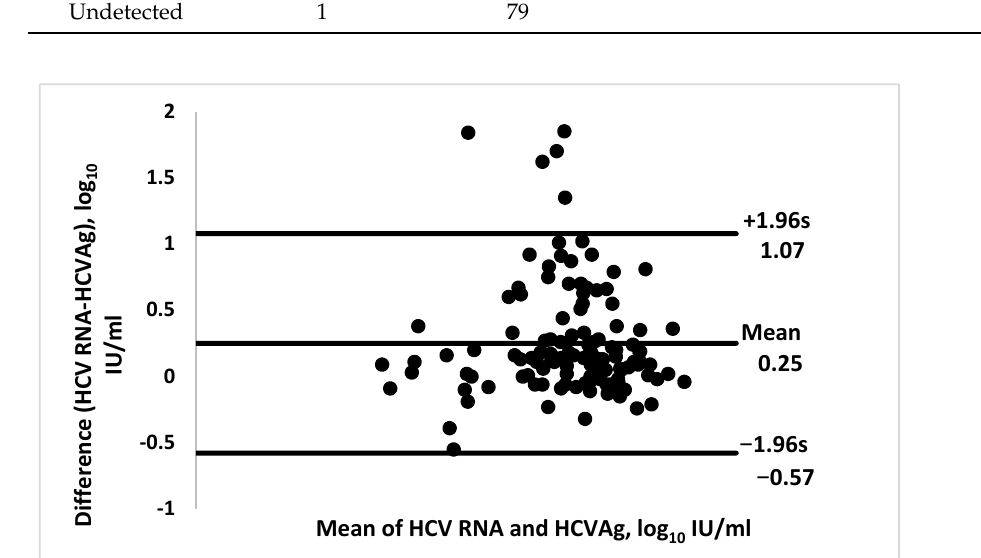
Figure 2. Relationship between the difference in HCV RNA and HCV core antigen (cAg), plotted against the mean of the two measurements in a Bland–Altman plot. The three lines in Figure represent mean of differences-called bias and the other two lines are limits of agreement mean +1.96 SD and mean − 1.96 SD. [The x axis represents the logarithmic mean levels of RNA and HCVcAg after conversion of HCVcAg to HCV RNA. The y-axis represents the logarithmic difference of RNA and